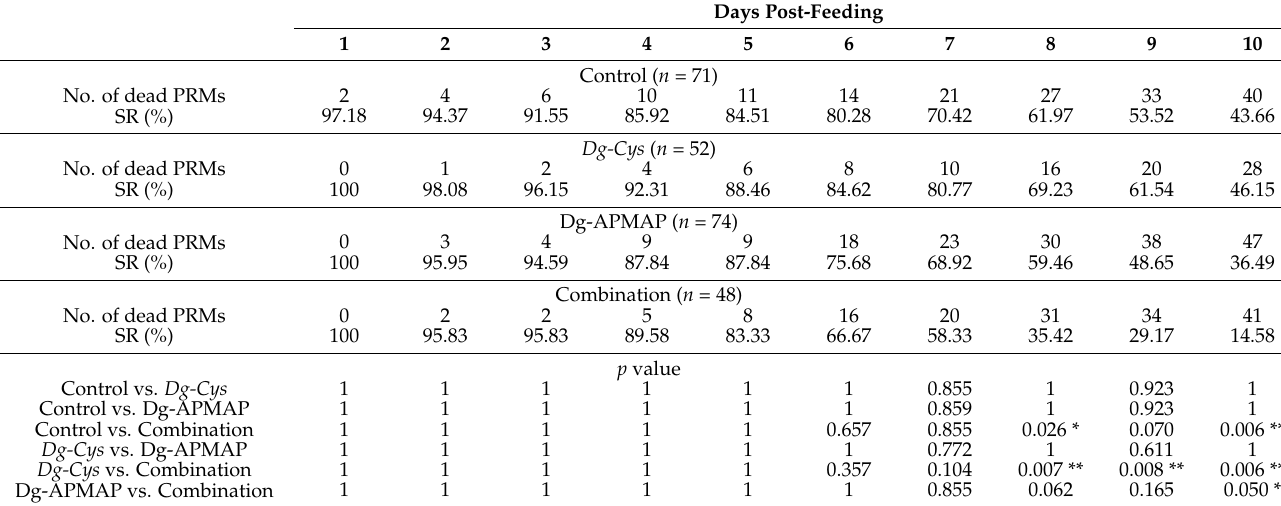
Table 4. Summary of the acaricidal effects of combined immune plasmas on adult mites ( Dg-Cys and